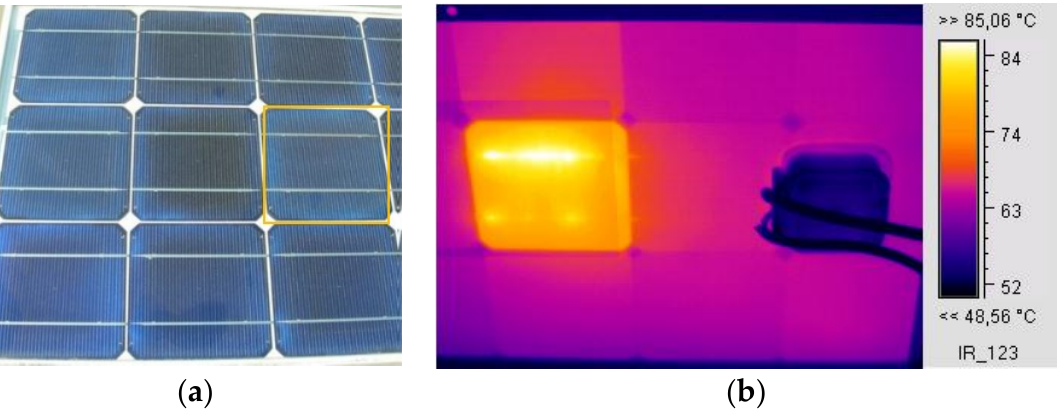
Figure 5. ( a ) Digital image from part of a 53 W p c-Si module with visible EVA and ARC degradation. ( b ) IR image captured from the back of the module showing hotspots on the busbars of the cell indicated in ( a ).